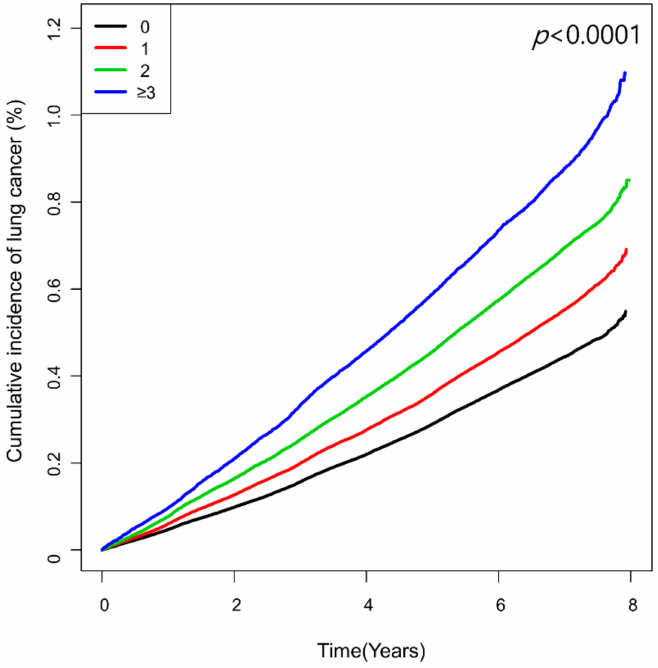
Figure 2. Kaplan–Meier curves showing cumulative incidence of lung cancer according to the number of high-variability parameters defined as the highest quartile of variability independent of the mean